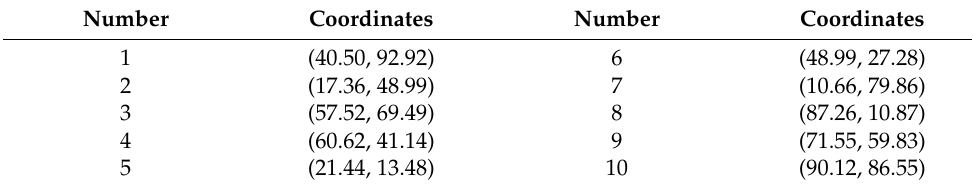
Table 5. Alternate physical store